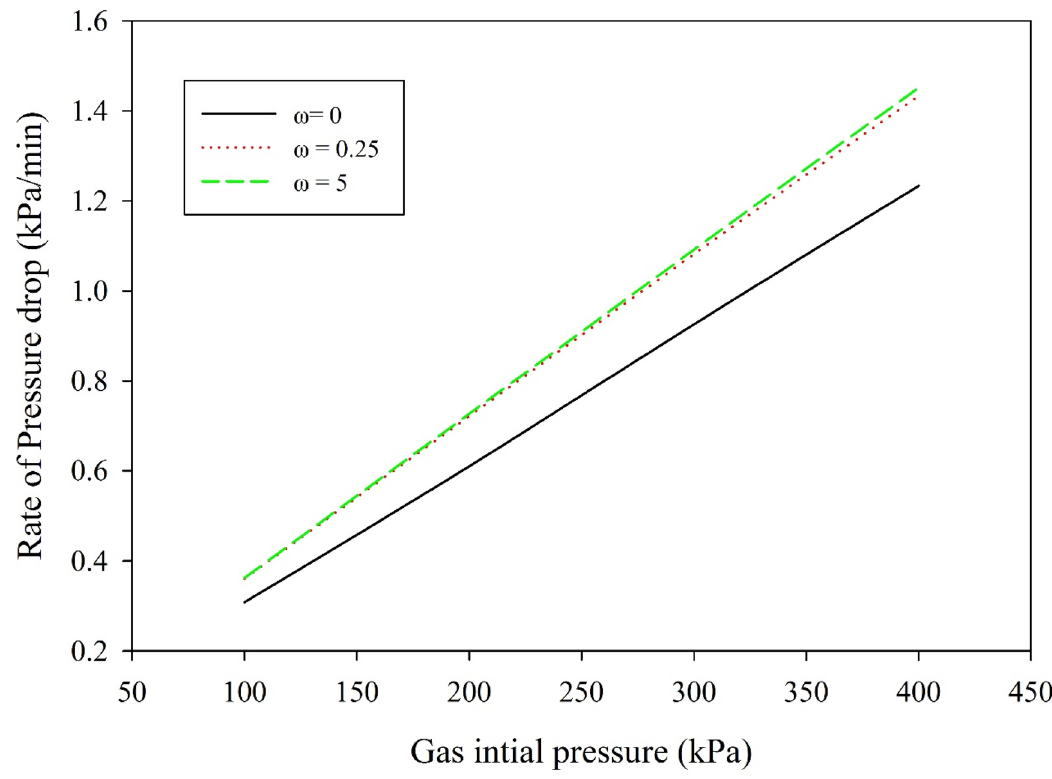
Figure 7. Effect of the initial gas pressure on the rate of CO 2 pressure drop at variable mixing rates; temperature is 25 °C; nanoparticle diameter is10 nm, with 0.1 wt% TiO 2 solid loading.